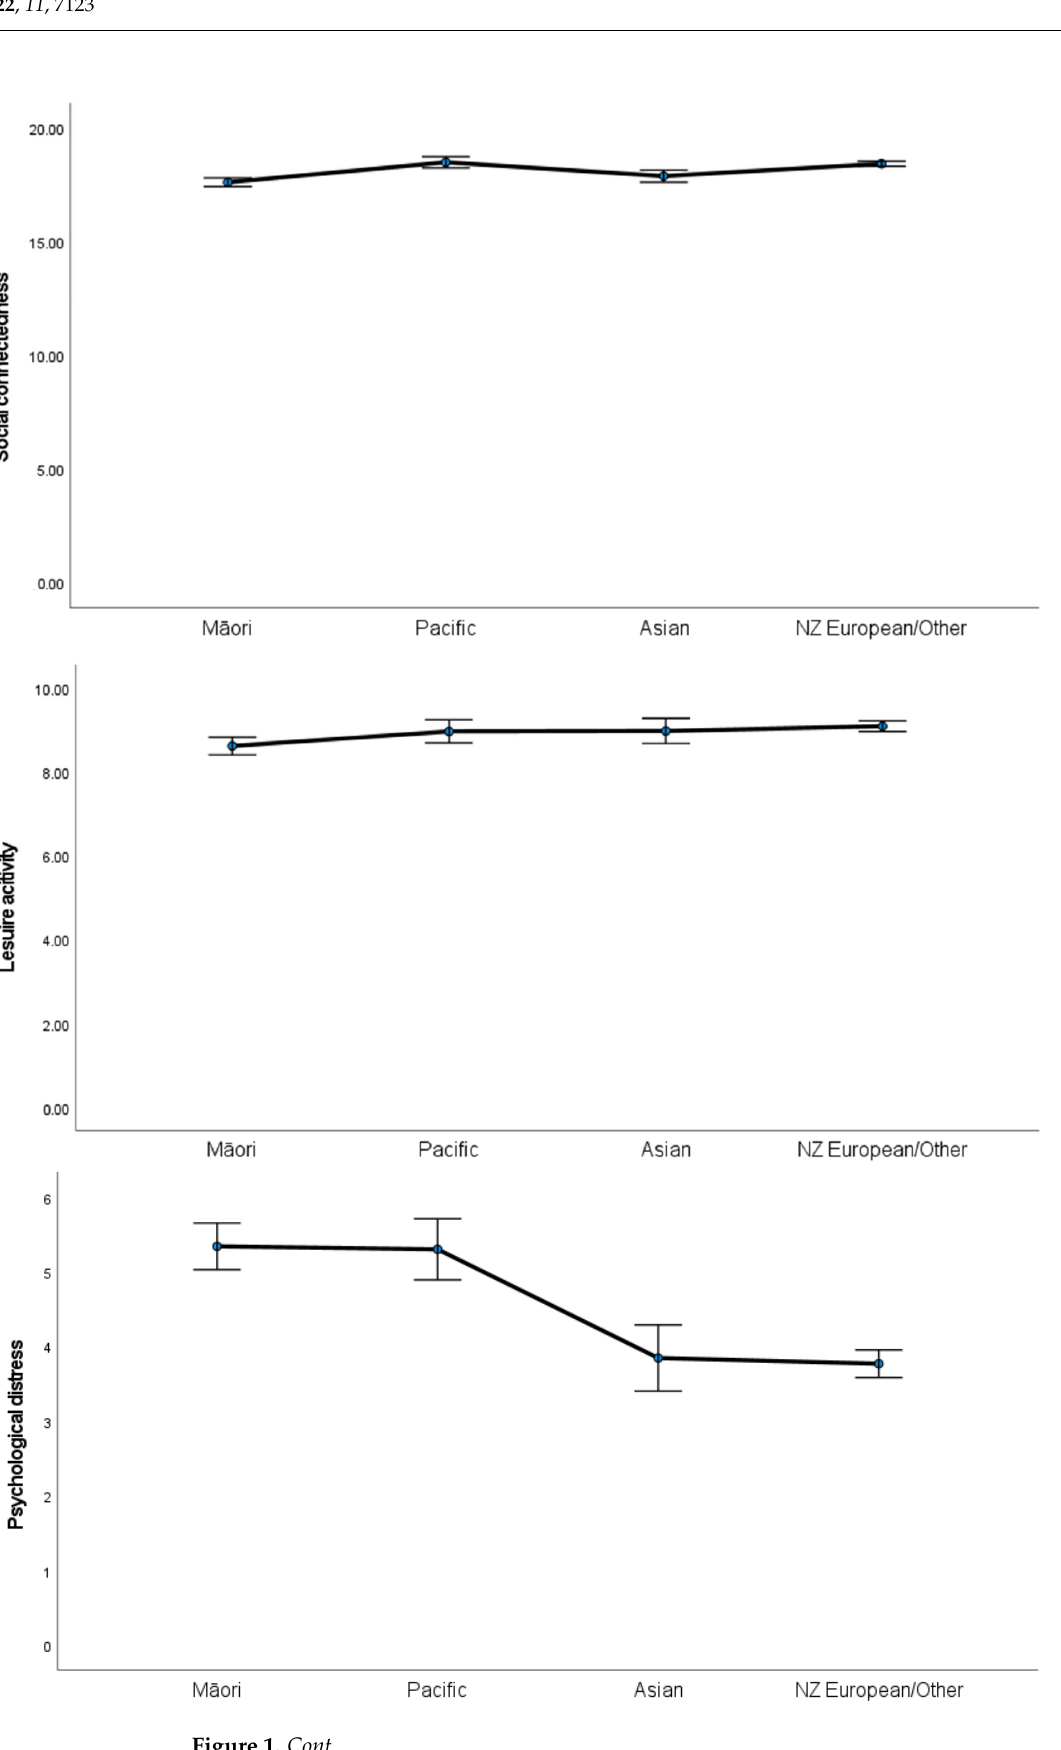
Figure 1. Mean and 90% confidence interval of gambling risk, social connectedness, leisure activi- ties, psychological distress, and quality of life among groups.